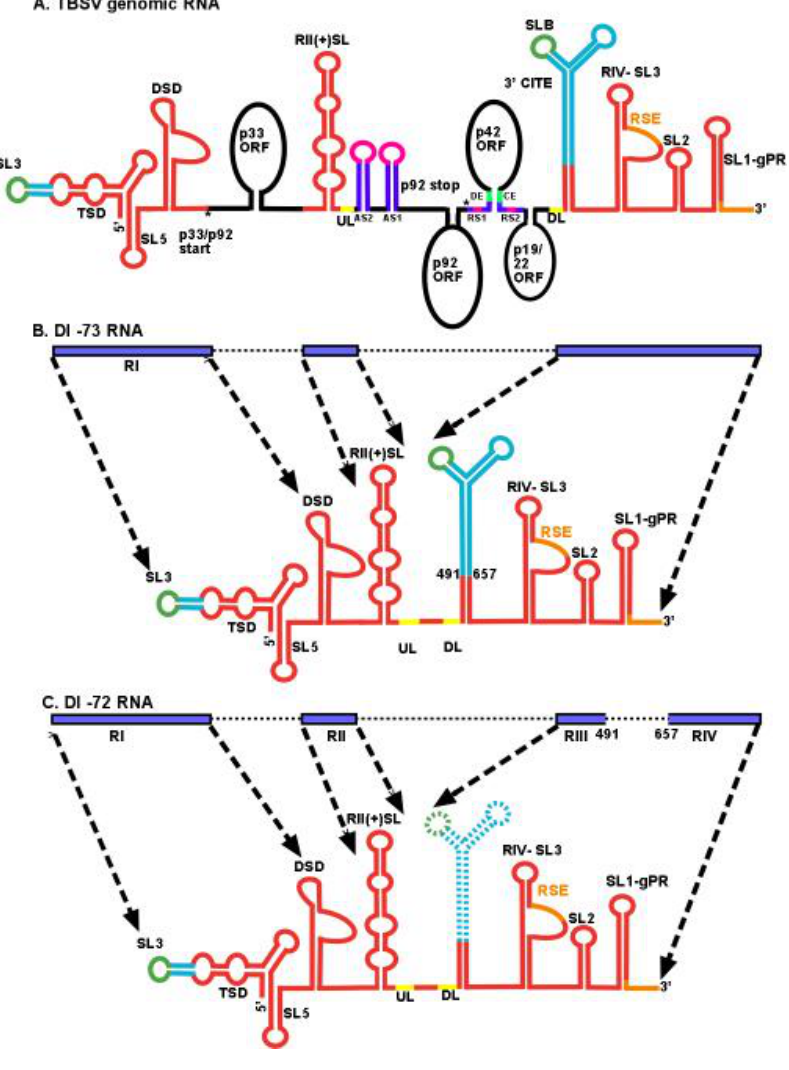
Figure 1. Genome and structural organization of TBSV genomic RNA and the prototypical DI-73 and DI-72 RNAs. (A) A cartoon showing structural details of the ~4,800 nt TBSV genome (not to scale). The p33, p92 pol , p41 and the overlapping p19/p22 ORFs are depicted as black ovals and labeled accordingly. Note that p92 pol overlaps with p33, sharing the same initiation codon. Sequences playing role(s) in translation, genome replication and sgRNA transcription are shown in turquoise blue, red and purple, respectively. Sequences involved in RNA-RNA interactions are shown in matching colors. Note that translation requires SL3-SLB interaction, UL-DL and RSE- gPR interactions are required for replicase assembly and AS1-RS1, AS2-RS2 and DE-CE interactions are crucial for sgRNA synthesis. (Abbreviations used are DSD: downstream domain; TSD: T-shape domain: RSE: replication silencer element; AS: activator sequence; RS: receptor sequence; CE: core element; DE: distal element; UL: upstream linker; DL: downstream linker; CITE: cap independent translation enhancer; SL: stem loop) [104] (B) Structure of the ~800 nt DI- 73 carrying three noncontiguous segments of the genomic RNA. Generation of DI-73 preserves critical replication elements (red) and the 3’CITE. The blue bars and dotted arrows depict the segments corresponding to genomic RNA. (C) Note that the other prototypical DI of ~620 nt, named DI-72 RNA, has an additional deletion of the